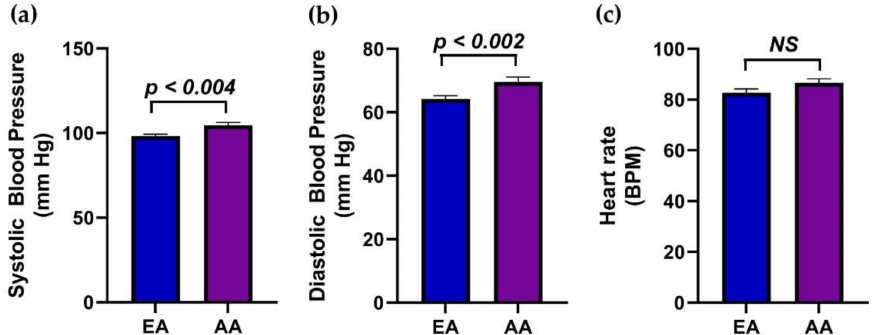
Figure 3. The blood pressure of EA and AA participants. The difference in the ( a ) systolic pressure, ( b ) diastolic pressure, and ( c ) heart rate between EA and AA children. Values are expressed as mean ±